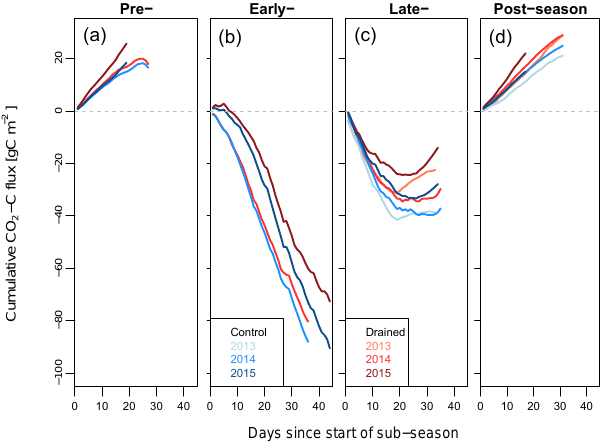
Figure 4. Webcam pictures representing the course of the 2015 growing season. All pictures were taken at noon in the middle of each sub-season: (a) mid-pre-season (6 June), (b) mid-early-season (10 July), (c) mid-late-season (9 August), and (d) mid-post-season (21 September).